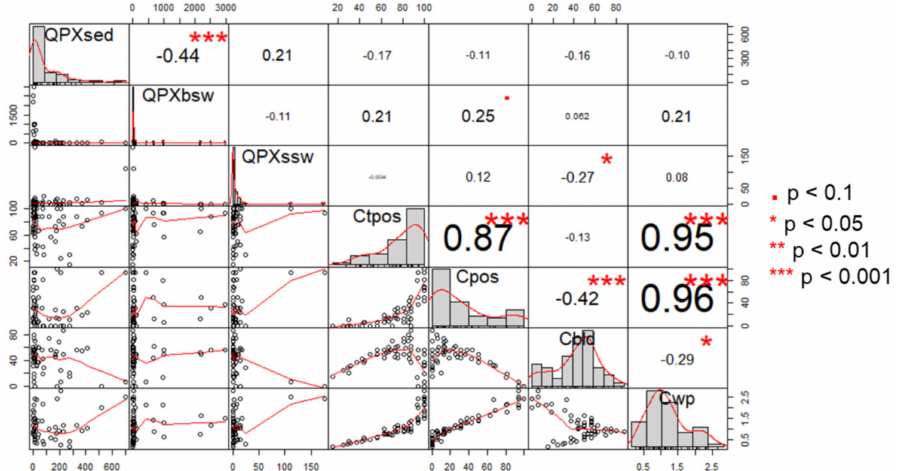
Figure 7. Spearman correlation coefficients (rho) correlogram with histograms for M. quahogii (QPX) in hard clam tissue (Ctpos, Cpos, Cbld, and Cwp represent clam tissue QPX prevalence: %TPOS, %POS, and %BLD and WP), and M. quahogii in the environment (QPXsed, QPXbsw, and QPXssw represent QPX abundance in sediment, BSW, and